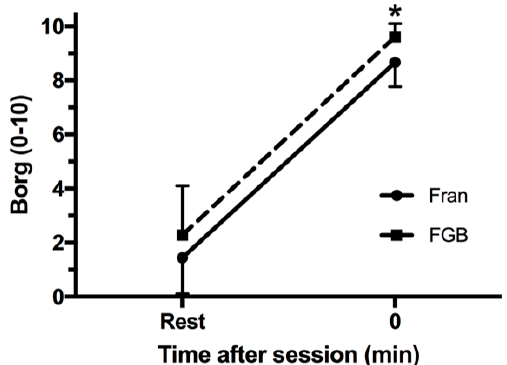
Figure 5. Rating of perceived exertion (RPE; 0 to 10) before and immediately after CrossFit ® sessions. * p ≤ 0.05 for rest for the two CrossFit ® sessions.